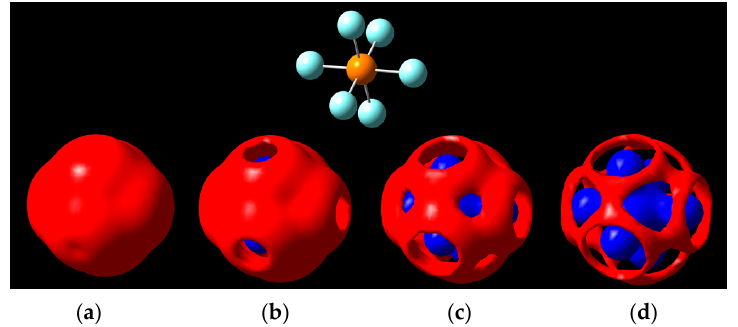
Figure 6. Isopotential surfaces of PF 6 − , separated between negative (red) and positive (blue) regions. Isopotential pairs are ( a ) ±5.1 V; ( b ) ±5.3 V; ( c ) ±5.5 V; and ( d ) ±5.7 V. A molecule is given for position reference (top).